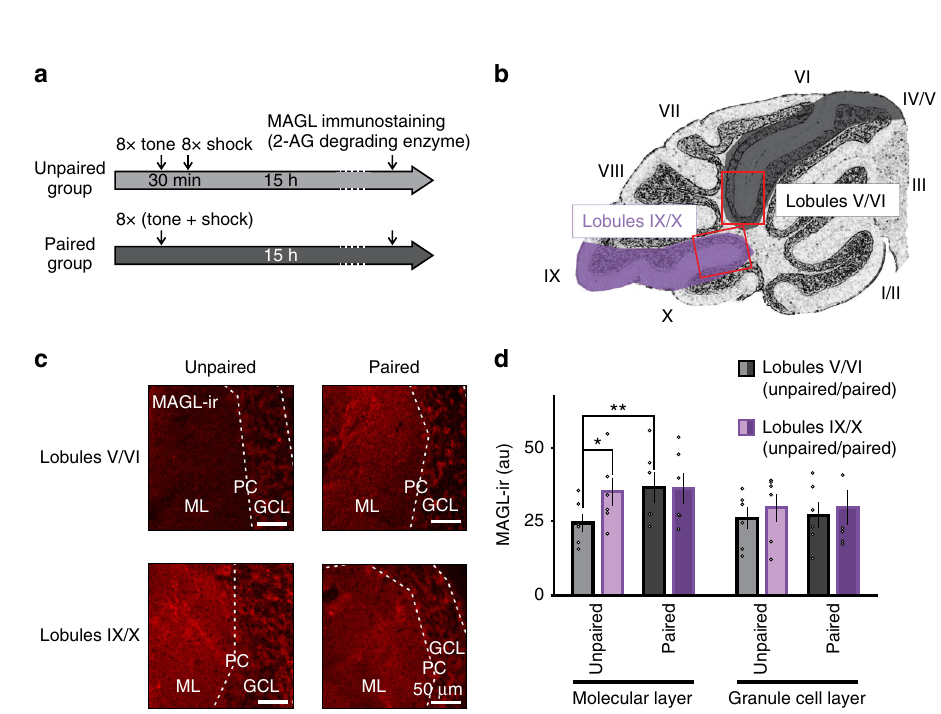
Fig. 6 Fear conditioning increases the expression of monoacylglycerol lipase (MAGL), a 2 - AG degrading enzyme, in lobules V/VI of the cerebellar vermis. a Experimental protocol. b Schematic illustration of a sagittal section of the cerebellar vermis and regions where images were taken (red boxes). c Representative immuno fl uorescence images of MAGL immunostaining in lobules V/VI and lobules IX/X of the cerebellum from unpaired and fear conditioned mice. d Group data showing a higher level of MAGL immunoreactivity (MAGL-ir) in the molecular layer of lobules V/VI compared to lobules IX/X in unpaired control animals ( n = 6 animals; ≥ 2 slices/animal). After fear conditioning ( n = 6 animals), MAGL expression is increased in lobules V/VI compared to unpaired controls. MAGL-ir levels in the granule cell layer of lobules V/VI is similar to lobules IX/X and is not affected by fear conditioning. Group comparisons were performed with a two-way RM ANOVA ( P = 0.021) followed by Tukey ’ s post hoc test (*, P = 0.008; **, P = 0.003). Data are presented as mean values ± SEM. Statistical analysis and P and F values can be found in Supplementary Table 4 and original data in the Source Data fi signi fi cantly reduced in conditioned mice (6.8 ± 1.8 ng/mg of tissue, Fig. 7a and Methods) relative to naïve (9.3 ± 2.4 ng/mg of tissue, P < 0.05, Fig. 7a) and unpaired controls (8.2 ± 2.9 ng/mg of tissue, P < 0.05, Fig. 7a). Therefore, there is an overall reduction in